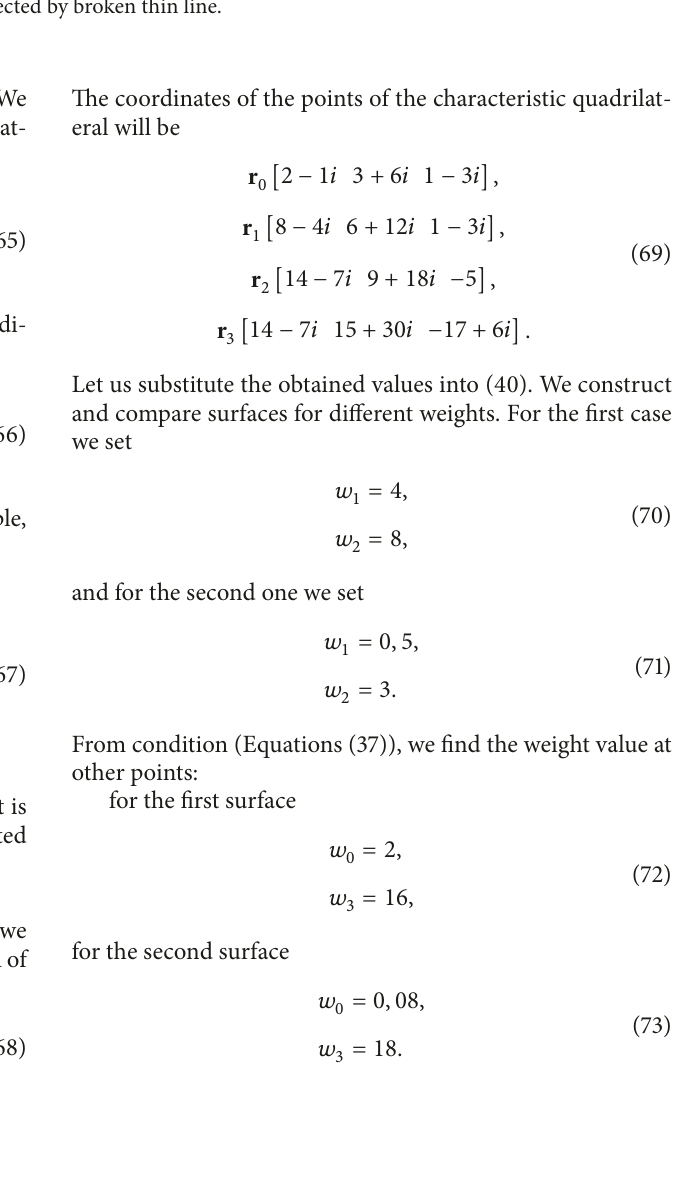
Figure 3: Real parts of cubic isotropic fractional-rational curves of the third order. Solid bold line corresponds to the isotropy condition and dashed bold line to their absence. The reference points are connected by broken thin